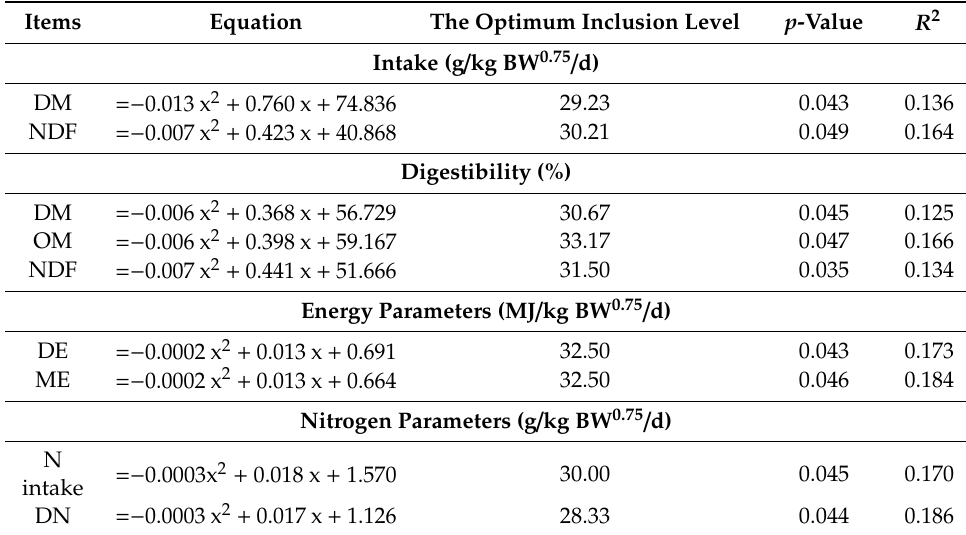
Table 6. Quadratic models between inclusion of C. deserticola and response